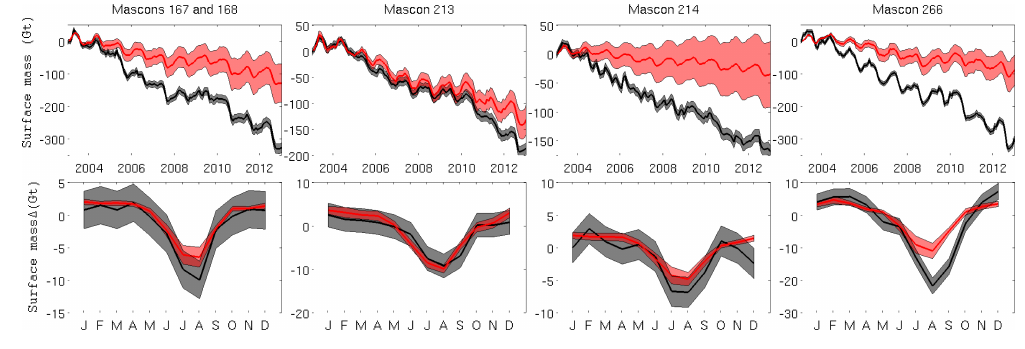
Figure 10. Same as Fig. 8 but for Southeast Greenland.